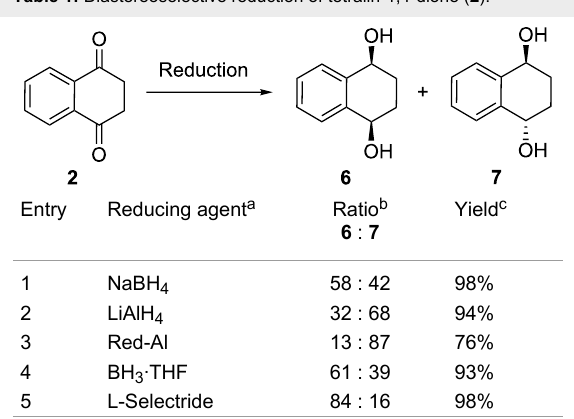
Table 1: Diastereoselective reduction of tetralin-1,4-dione ( 2